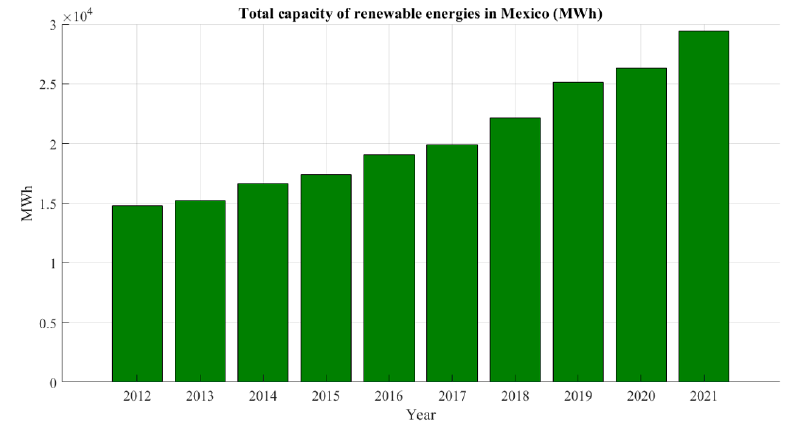
Figure 1. The total capacity of renewable energies in Mexico (2012–2021). The proportion of RE in the total electrical capacity in Mexico is shown in Figure 2; the trend of increased participation of RE in Mexico has been positive in the last